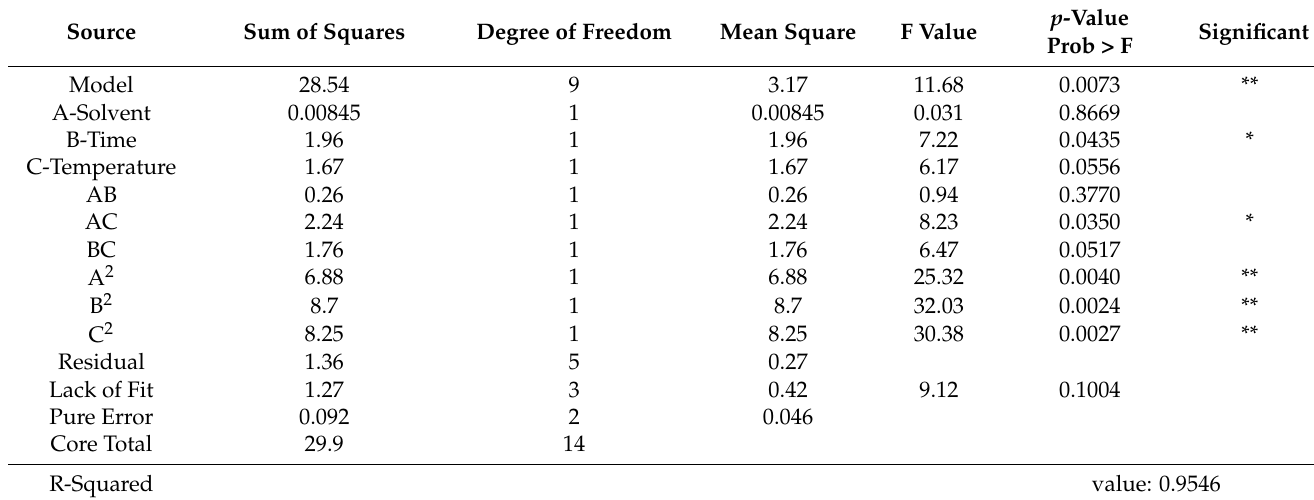
Table 4. Analysis of variance of RSM for CA